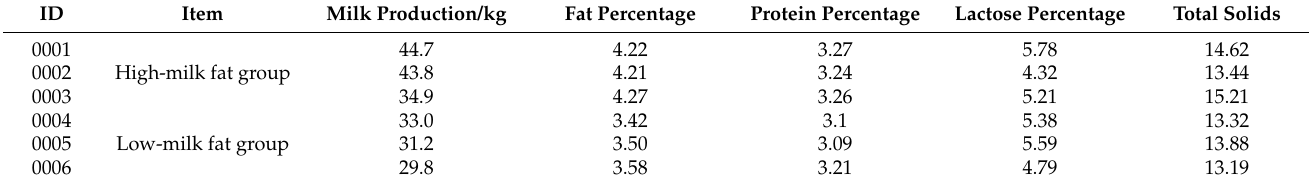
Table 6. DHI analysis of milk (%).